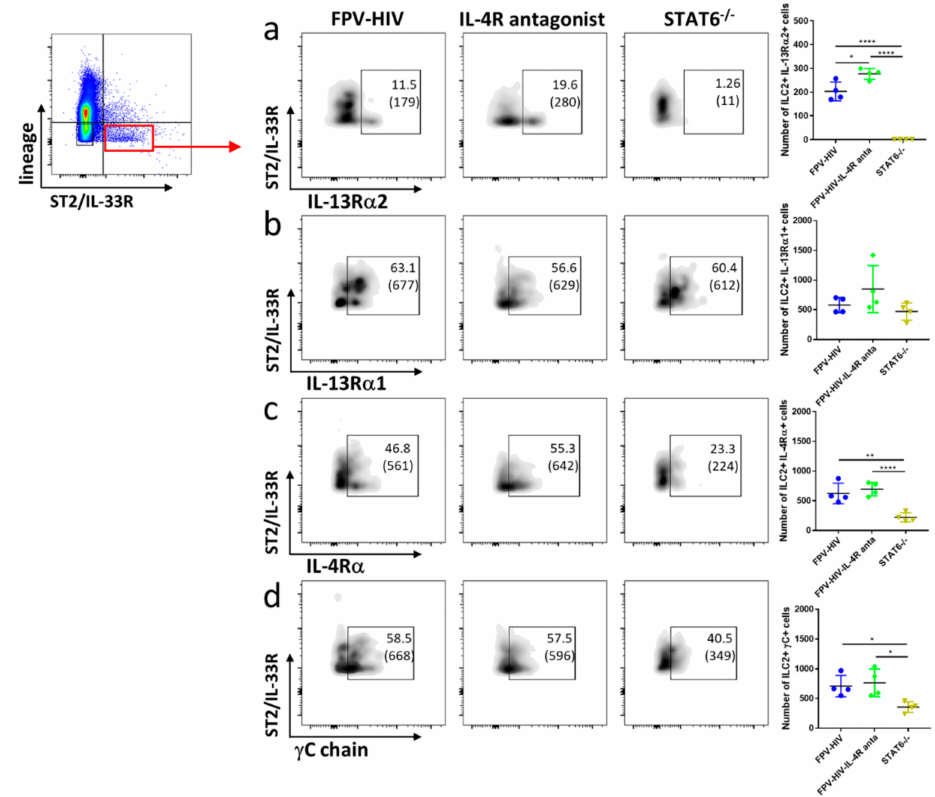
Figure 2. Evaluation of lung lineage − IL-33R/ST2 + ILC2 expressing type I ( γ C/IL-4R α ), type II (IL-4R α /IL-13R α 1) IL-4 receptor complexes and IL-13R α 2 following vaccination under permanent vs. transient inhibition of STAT6. WT BALB/c and STAT6 − / − mice on BALB/c background (n = 4) were immunized intranasally with FPV-HIV-IL-4R antagonist adjuvanted or FPV-HIV unadjuvanted vaccines, respectively. Color coded vaccine groups represent: blue, WT BALB/c given FPV-HIV (control); green, WT BALB/c given FPV-HIV-IL-4R antagonist vaccine (which represents transient IL-4/IL-13/STAT6 signaling inhibition condition); and yellow, STAT6 − / − given FPV-HIV (which represents permanent STAT6 signaling inhibition condition). Lung ILC2s were identified as CD45 + FSC low SSC low lineage − IL-33R/ST2 + cells. The FACS plots in each panel indicate the percentage of ILC2 expressing IL-13R α 2 ( a ), IL-13R α 1 ( b ), IL-4R α ( c ), and γ C chain ( d ) in each vaccinated group. The bracket below the cell percentage indicates the number of cells is each gate. The graph in each panel represents the number of ILC2s expressing the different receptors back calculated to CD45 + population as described in the materials and methods (24 h post vaccination). The error bars represent the mean and standard deviation (s.d.). The p values were calculated using one- way ANOVA using Tukey’s multiple comparisons test and unpaired t -test. * p < 0.05, ** p < 0.01, **** p < 0.0001. Experiments were repeated a minimum of 3